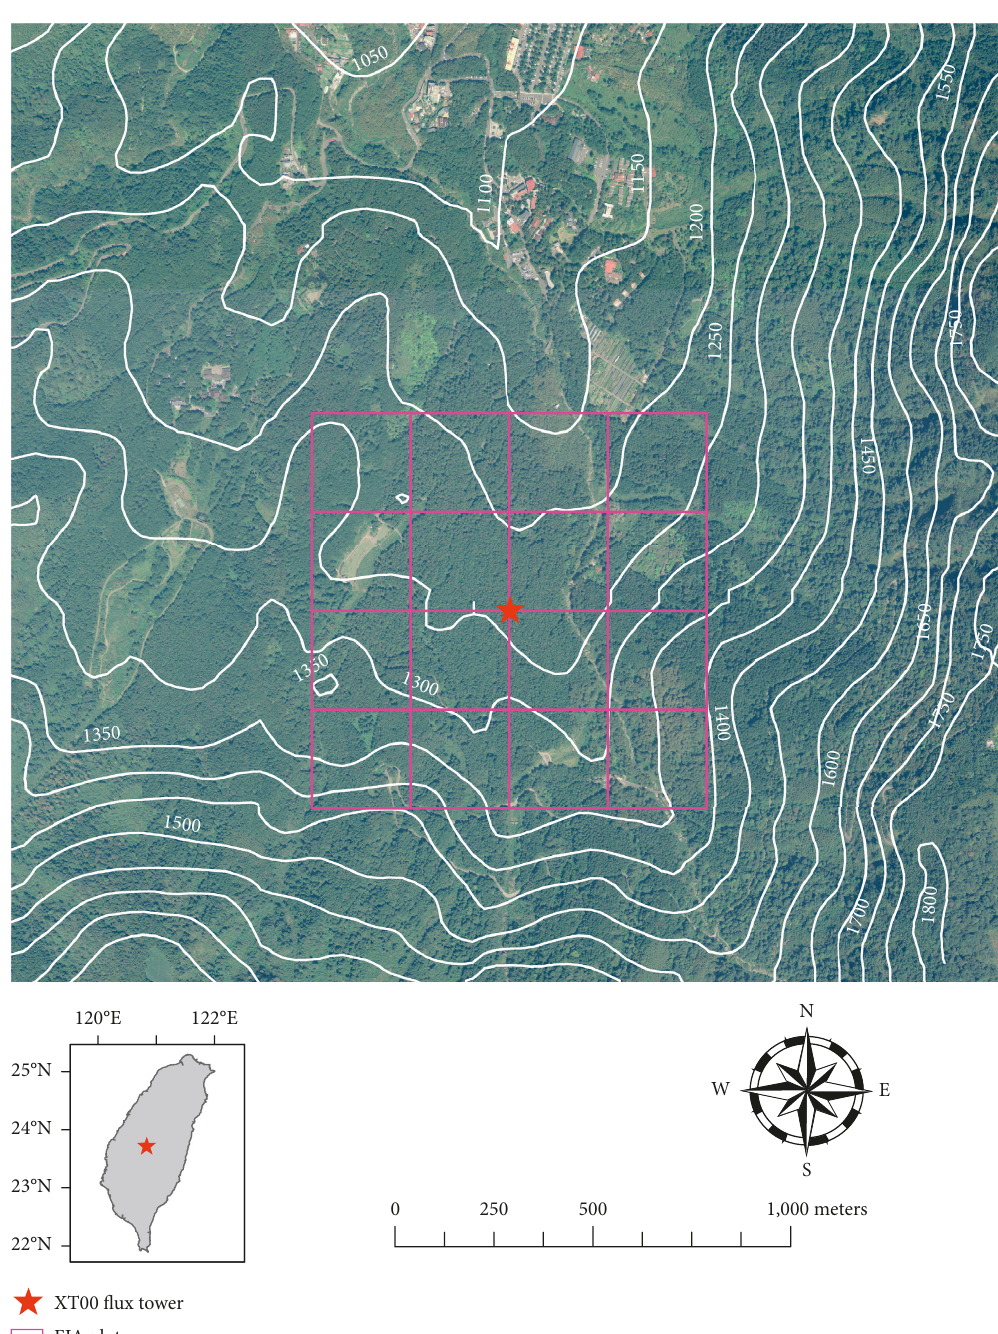
Figure 1: Map of the Xitou area with the location of the eddy covariance tower and the Forest Inventory and Analysis (FIA) plot design (purple squares; plot size 250 250 ×